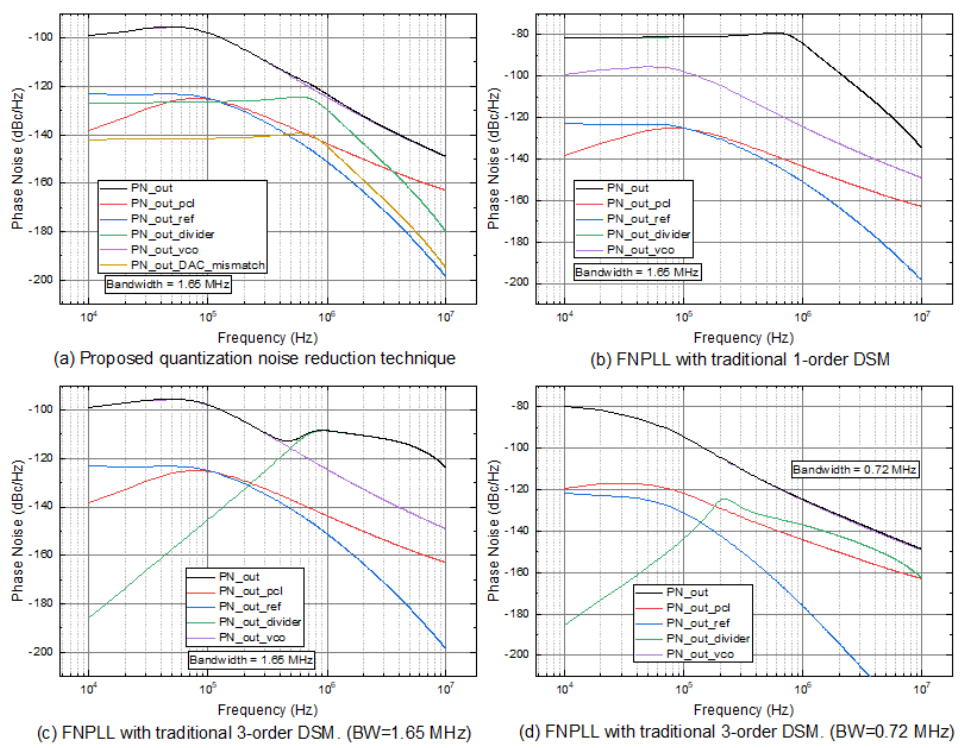
Figure 11. Output phase noise of the PI FNPLL.